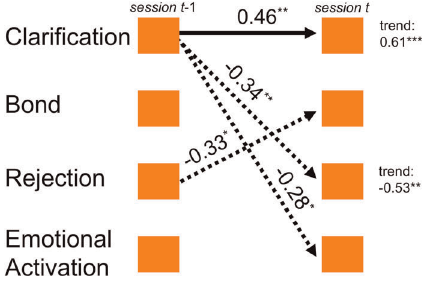
Figure 3. Process model of the SET patients sample. Process model of the SET patients sample (n=69), after aggregation by TSPA. Arrows indicate those time-lagged associations between components whose sample means deviate significantly from zero. Mean parameter values printed next to respective arrows (*, p , .05; **, p , .01). Negative associations: dotted arrows. Significant linear trends are printed right.